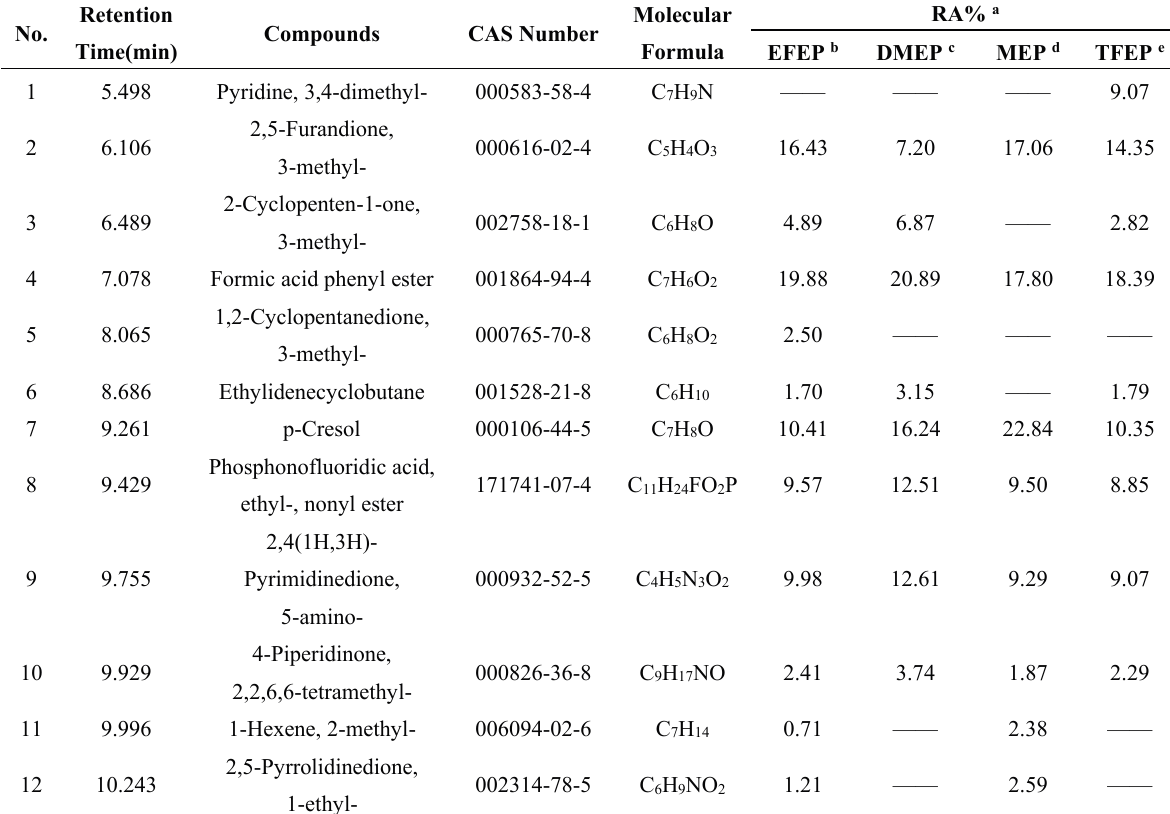
Table 5. Volatile compounds in PA-200